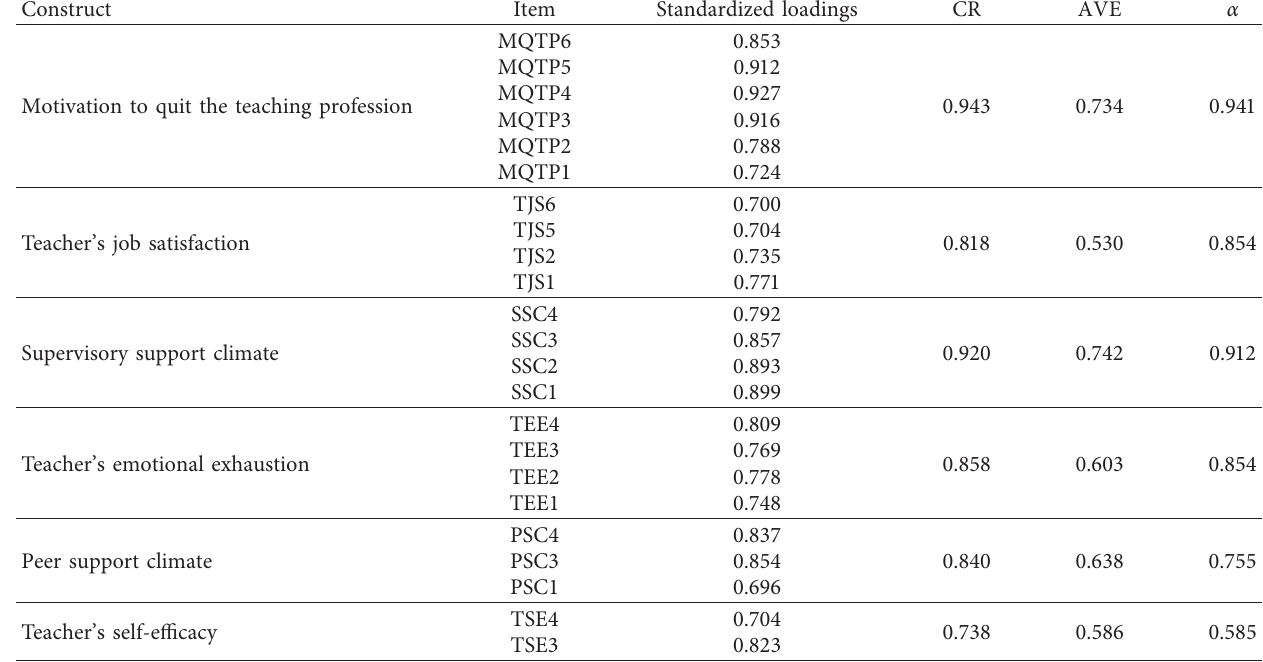
Table 4: CFA results of final measurement model.